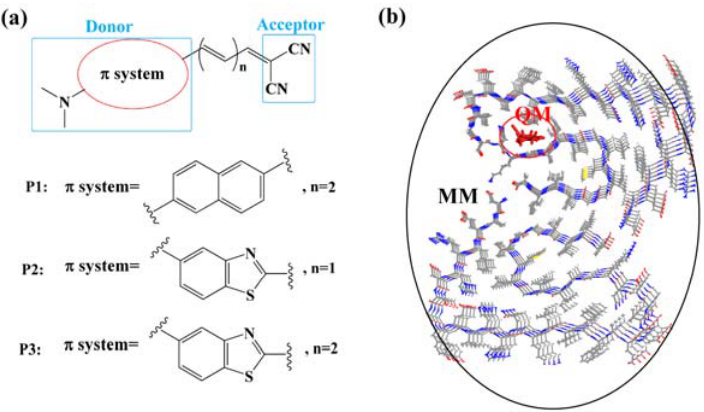
Figure 1. ( a ) Molecular structures of P1, P2, P3, and ( b ) the division of quantum mechanics (QM) and molecular mechanics (MM) regions in amyloid-ligand configuration.